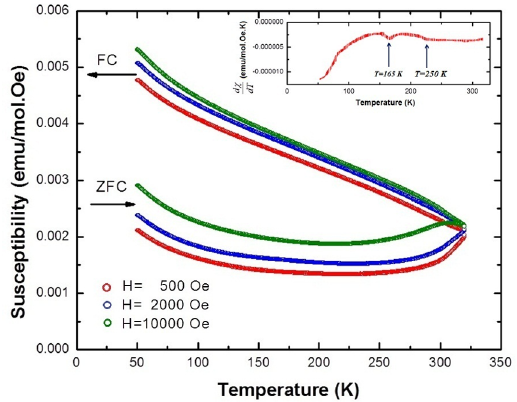
Figure 7. Magnetic susceptibility as a function of temperature for the LaBiFe O material on the application of H=500 Oe , 2000 2 6 Oe and 10000 Oe . The inset shows the temperature derivative of susceptibility for H=500 Oe